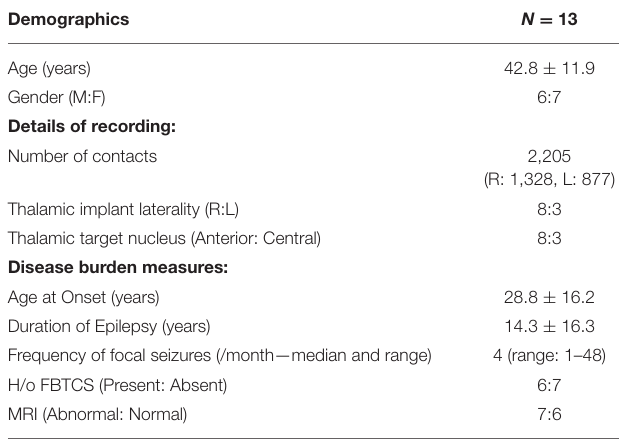
TABLE 1 | Demographic details of the study